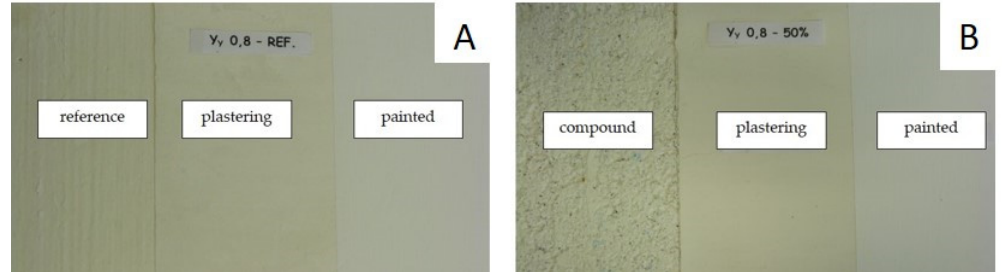
Figure 10. Board finishes: ( A ) Reference board; an ( B ) composite board with